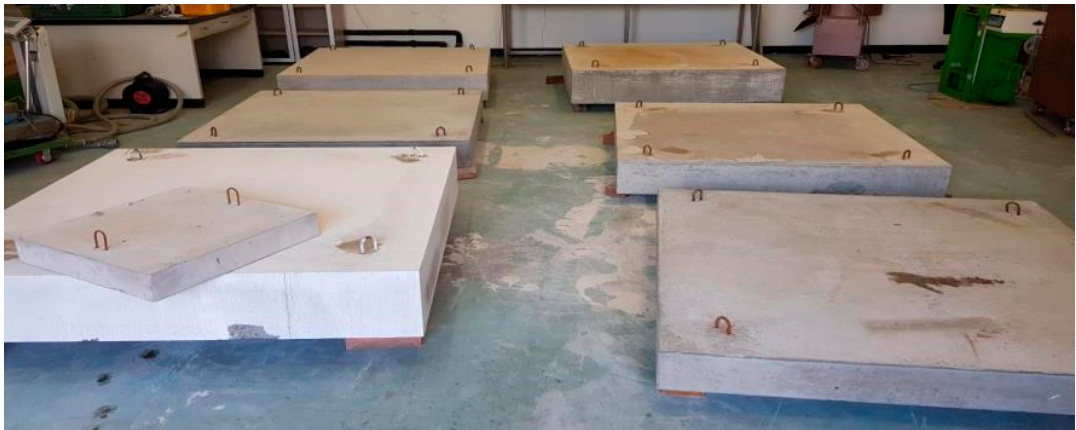
Figure 7. Test slabs for the ultrasonic velocity measurements.